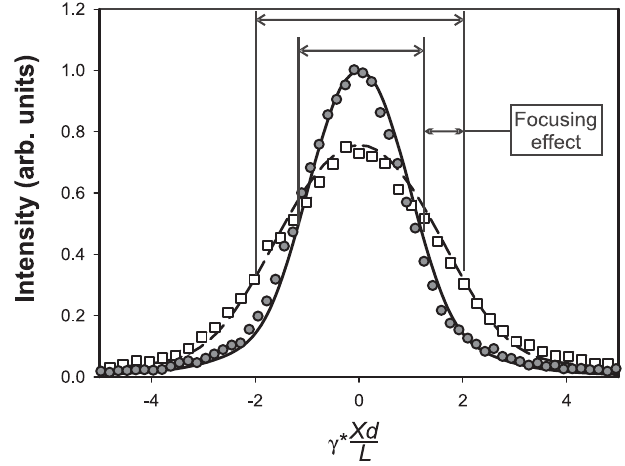
FIG. 6. The OTR vertical polarization component spatial dis- tributions along the Xd direction ( Yd ¼ max ). Gray dots— spherical target experiment; white squares—flat target experi- ment; solid line—spherical target theory; dashed line—flat target theory.